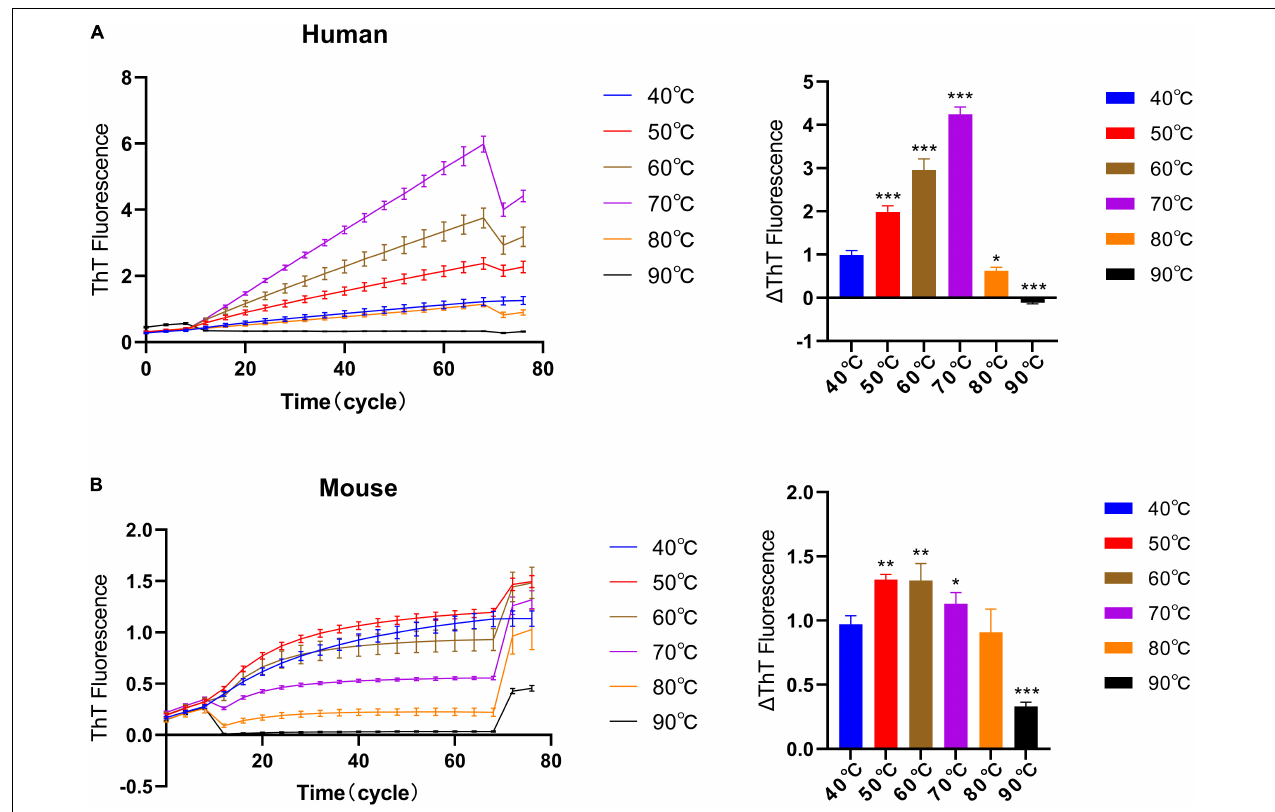
FIGURE 3 | The effect of different incubation temperatures on the quiescent incubation curve of fibril seeds. Fluorescence values were collected in another 10 incubation cycles at 40 ◦ C at the start and end of the incubation assay to correct the effects of different temperatures on ThT fluorescence intensity. (A) Quiescent incubation curve of human α -synuclein fibril seeds + human α -synuclein monomer under different temperature conditions, left. Corresponding (cid:49) ThT fluorescence value, right. The optimal temperature for the human homologous reaction is 70 ◦ C. (B) Quiescent incubation curve of mouse α -synuclein fibril seeds + mouse α -synuclein monomer under different temperature conditions, left. Corresponding (cid:49) ThT fluorescence value, right. The optimal temperature for the mouse homologous reaction is 60 ◦ C. All data are expressed in mean ± SD. Compared with the 40 ◦ group, * P < 0.05, ** P < 0.01, *** P <